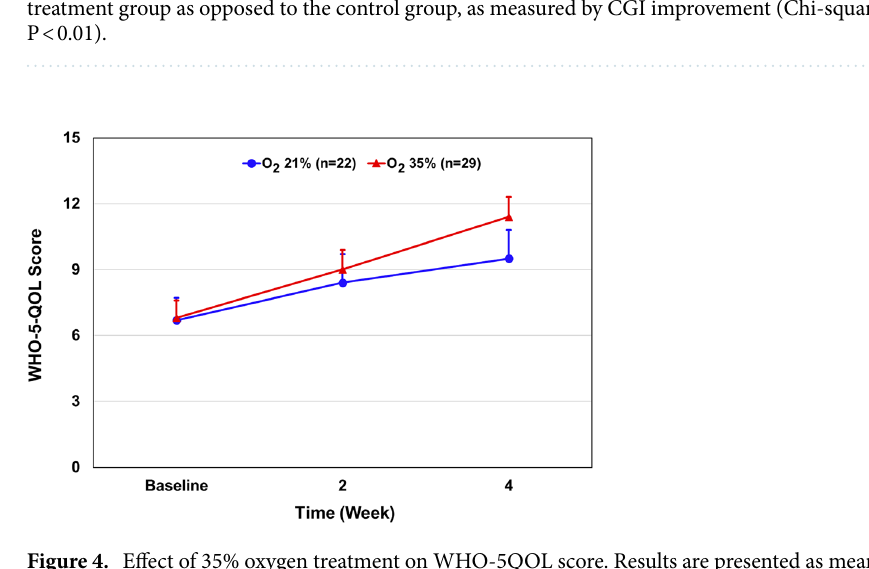
Figure 4. Effect of 35% oxygen treatment on WHO-5QOL score. Results are presented as mean ± SEM. Multivariate regression analysis: The mean ± SD changes in the scores from baseline to week four were 4.5 ± 0.5 points in the oxygen-treated group and 2.6 ± 1.44 in the control group, for a between-group difference of 1.9 points (95% CI − 1.08 to 1.86; P =